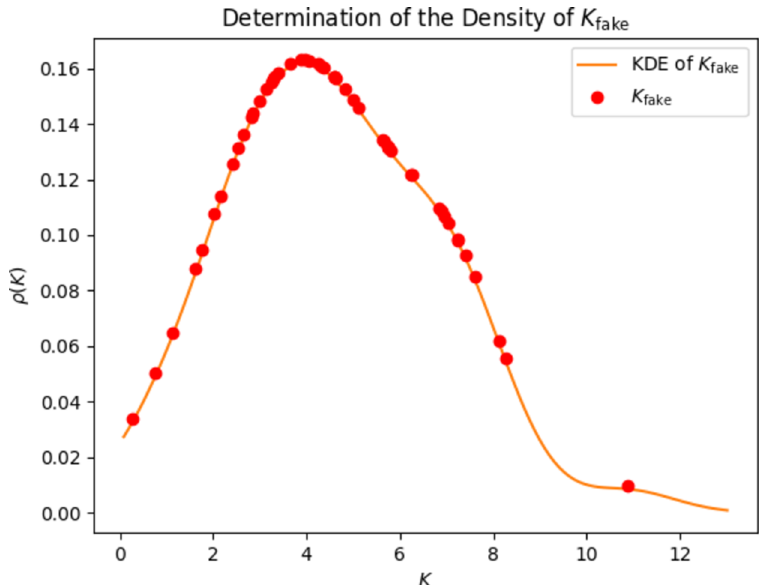
Figure 6 . The density of the test statistic K under the SM-only hypothesis obtained using a Kernel Density Estimator (KDE). The K values generated by the runs over 50 fake databases are shown as red points (see text for